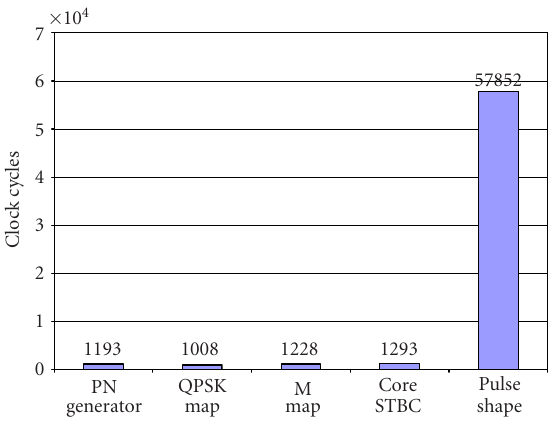
Figure 4: Profiling results of the transmitter code structure (number of DSP clock